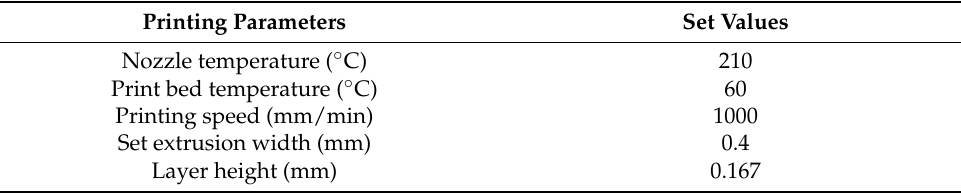
Table 2. 3D Printing parameters for the PLA